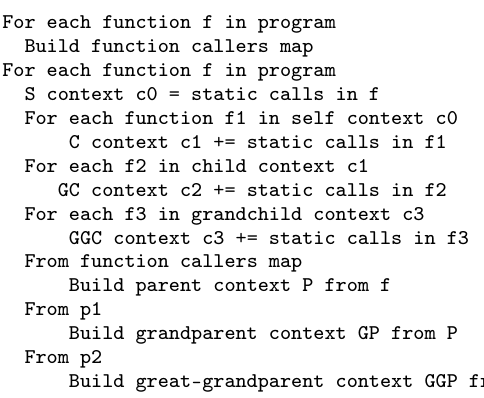
Figure 2. Function Context Extraction Algorithm.